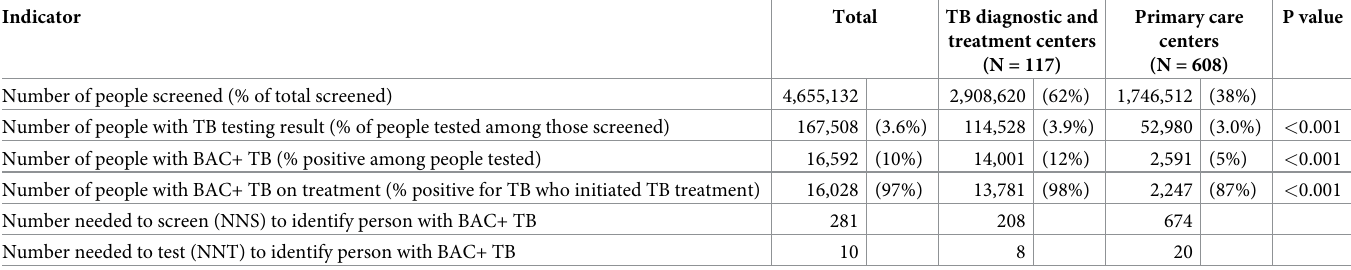
Table 1. Tuberculosis screening cascade for activities at 117 TB diagnostic and treatment centers and 608 primary care centers during intervention (2019–2020). Indicator Total TB diagnostic and